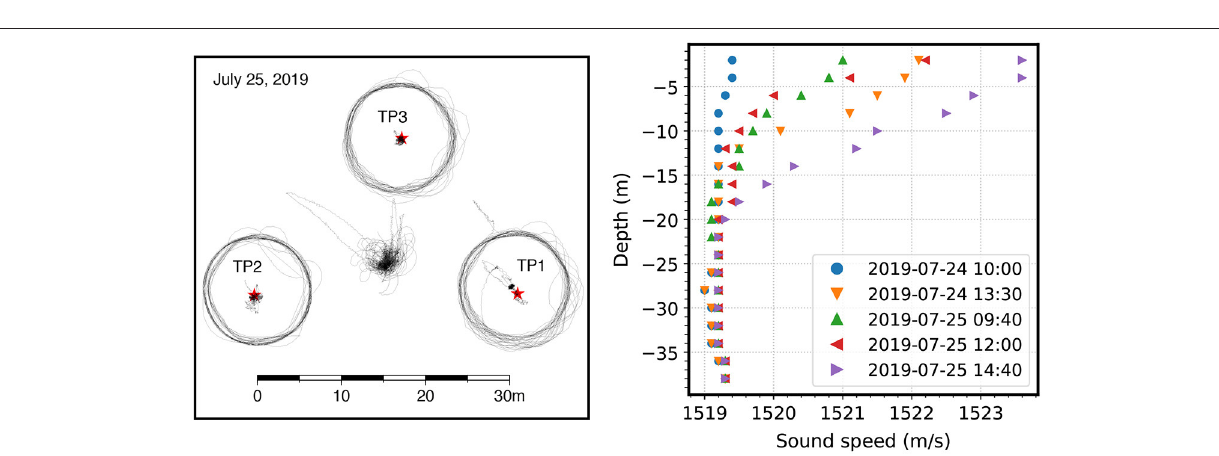
has a range accuracy of 2 cm and a bearing accuracy of 0.03 ◦